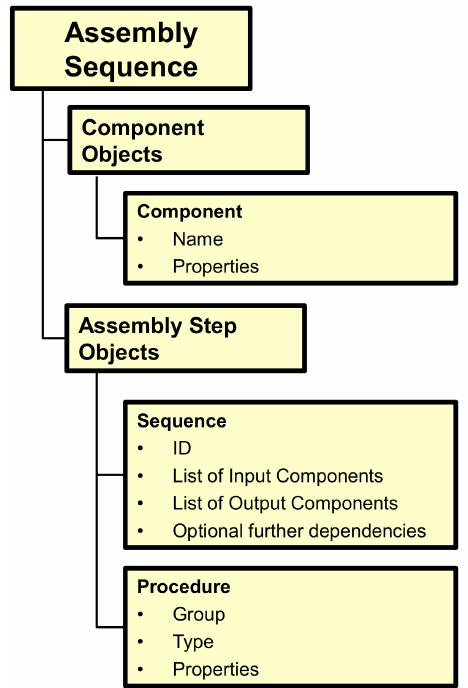
Figure 7. Overview of the hierarchical object structure of the assembly sequence JSON